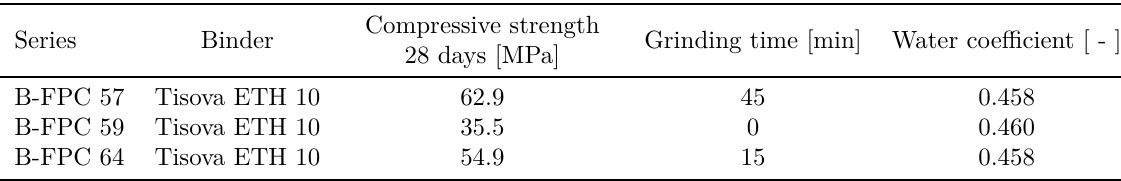
Table 2. Features of the B-FPC series 57, 59, 64 [19].